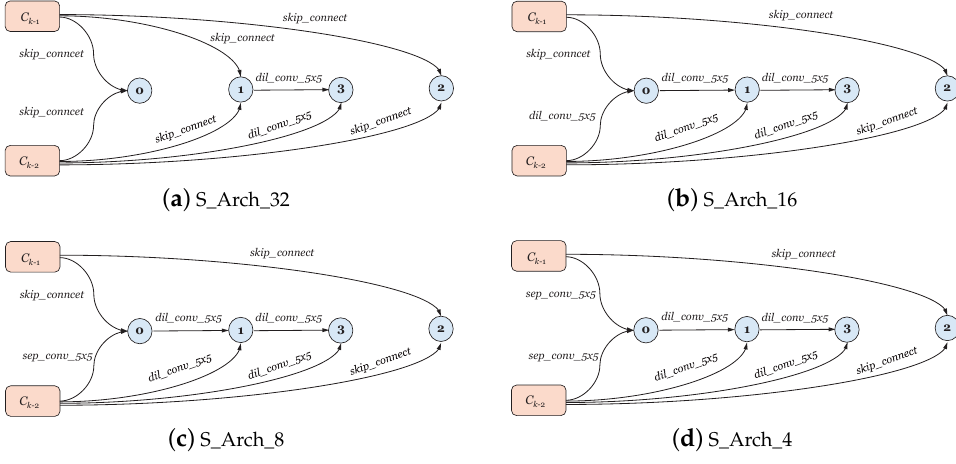
Figure A5. Cell structures obtained over SSDD with ops _ ratio =